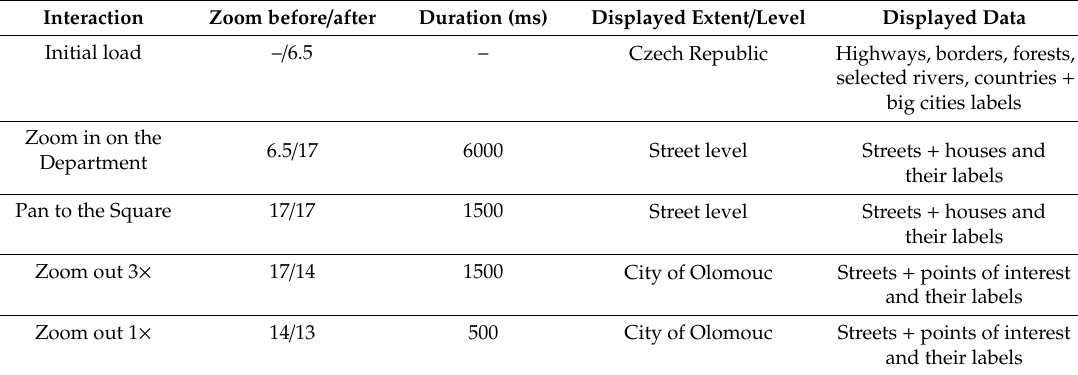
Table 2. List of interactions during